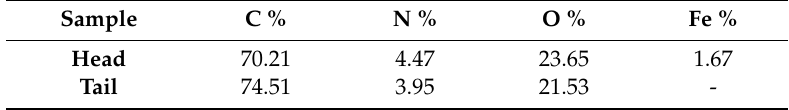
Figure 6. IR spectra of (a) control fibers and (b) MI fibers ( A ) and (a) pure RA and (b) RA–PAM complex in deuterated solvent ( B ). Table 2. Chemical composition of molecularly imprinted (MI) beaded fibers (in atom